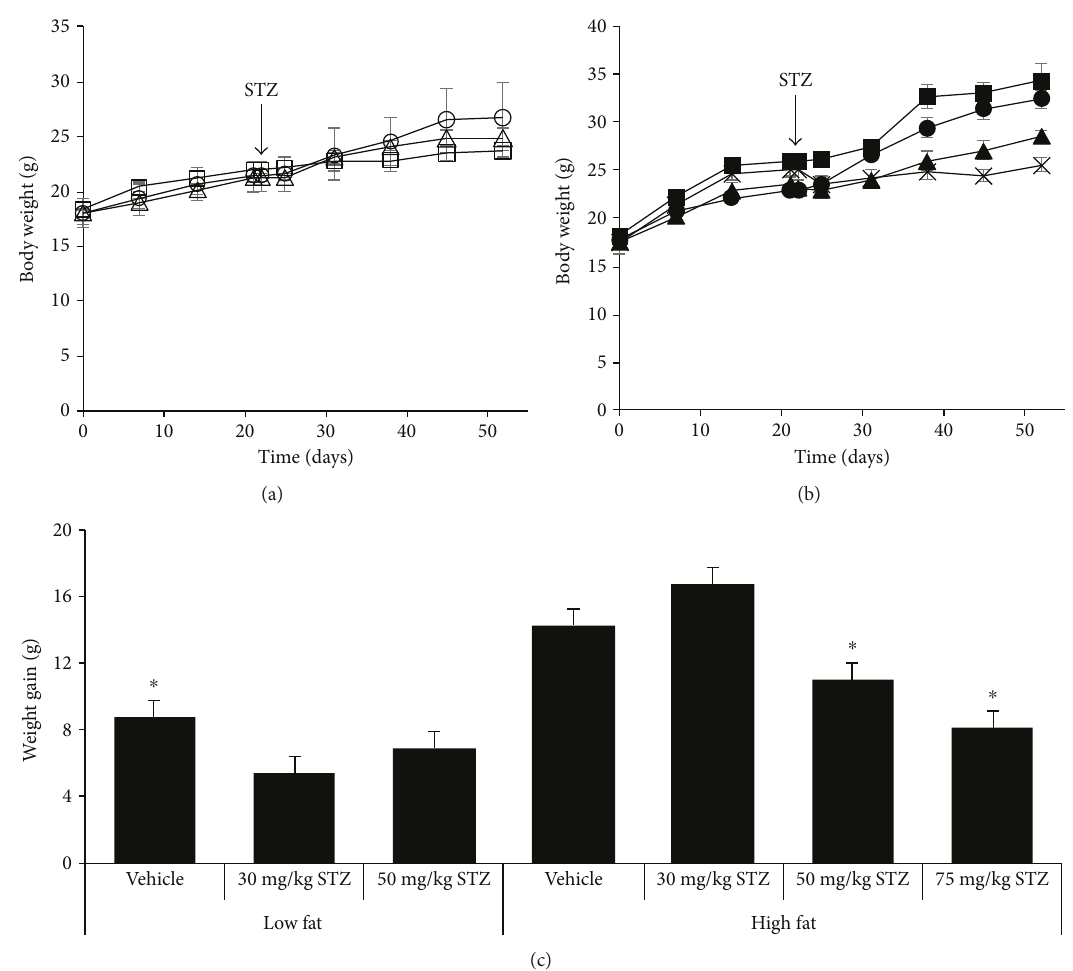
Figure 1: Body weight over time in low (a) and high (b) fat-fed mice treated with three consecutive once-daily doses of vehicle or 30, 50, or 75mg/kg STZ. (c) Body weight gain from entry (day 0) to week 4 after vehicle or STZ treatments. Treatment groups are denoted as follows: low fat — vehicle, open circles ( n = 4 ); low fat — 30mg/kg STZ, open squares ( n = 4 ); low fat — 50 mg/kg STZ, open triangles ( n = 4 ); high fat — vehicle, closed circles ( n = 4 ); high fat — 30mg/kg STZ, closed squares ( n = 3 ); high fat — 50mg/kg STZ, closed triangles ( n = 6 ); and high fat — 75 mg/kg STZ, × ( n = 3 ). Data are means ± SEM . ∗ p < 0 05 versus high fat —